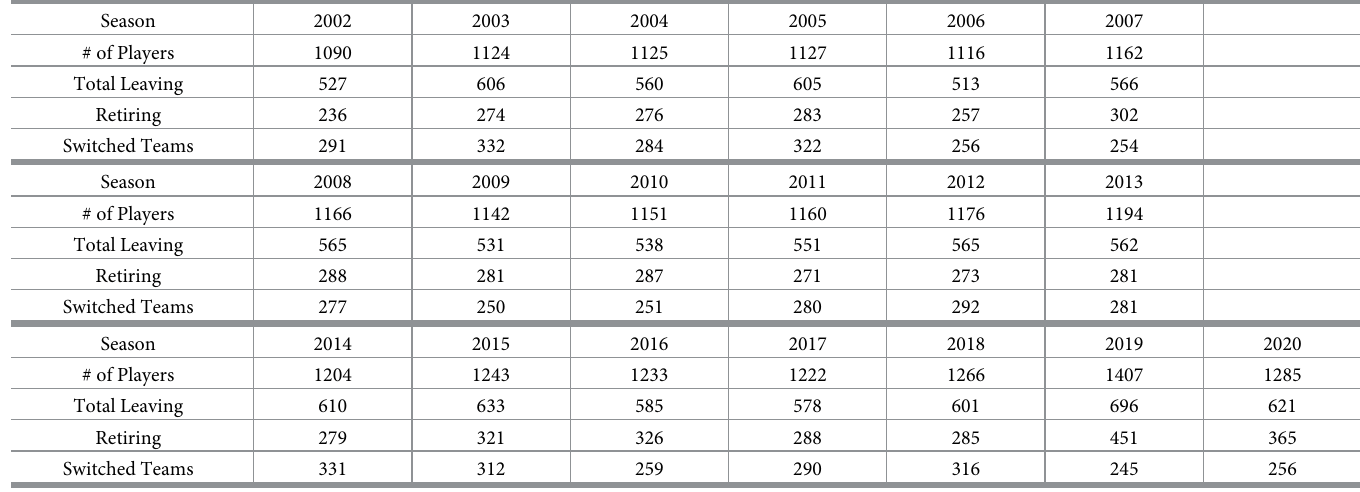
Table 2. The number of Major League baseball players per year comprising the 2002–2020 baseball seasons. We observe that each year 48.7% of the players leave their current team on average. Of those that transition about one-half, 49.0%, of the players transition to a new team and the other half of the players end their professional